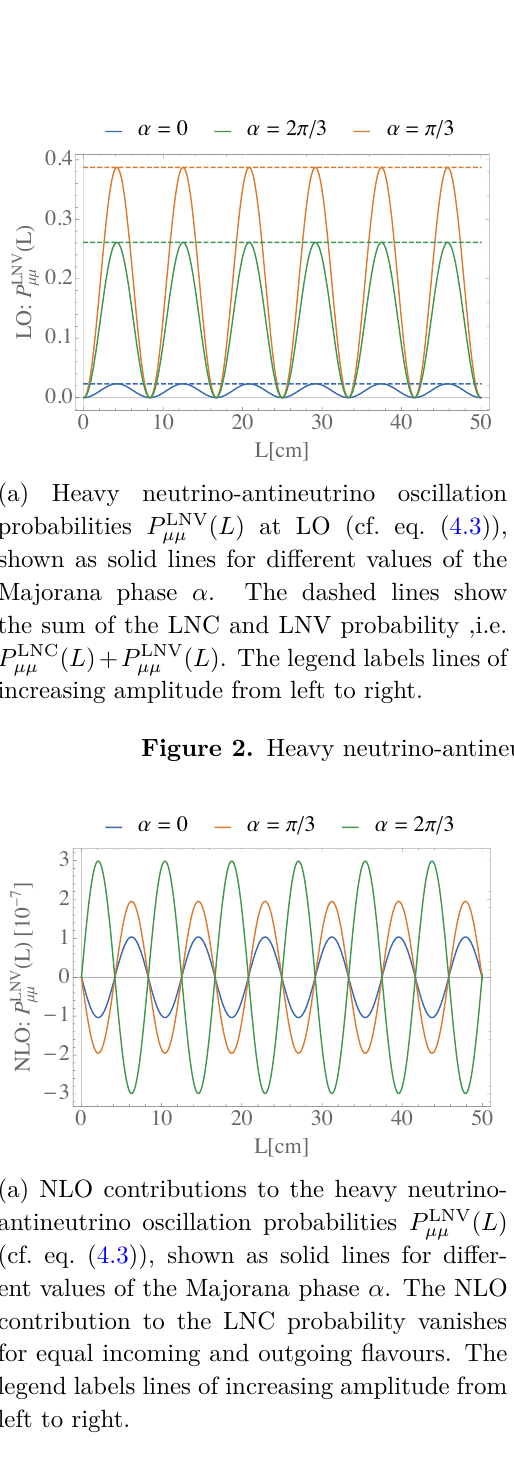
Figure 3. NLO contributions to the heavy neutrino-antineutrino oscillation